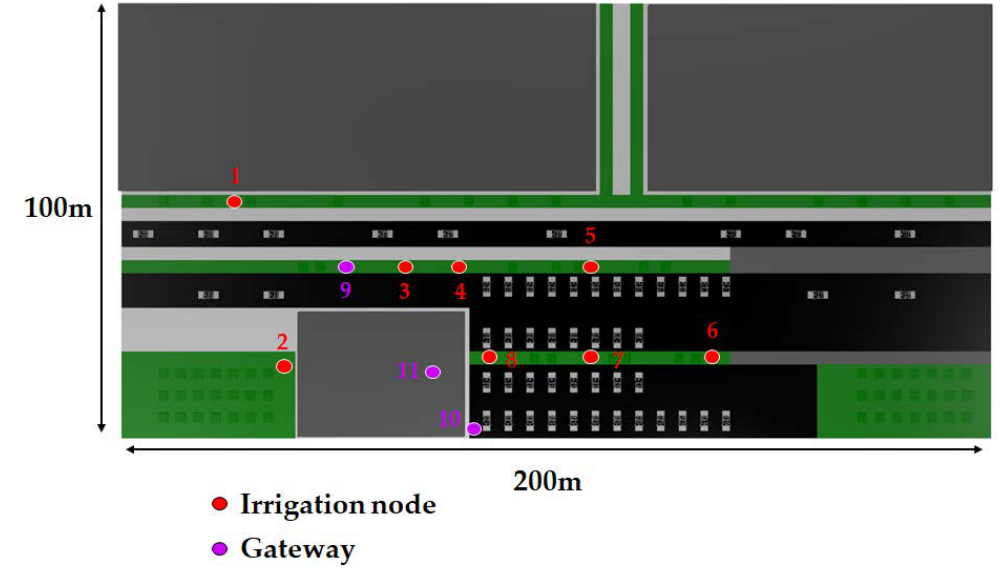
Figure 10. Schematic upper view of the deployment of the irrigation nodes and the